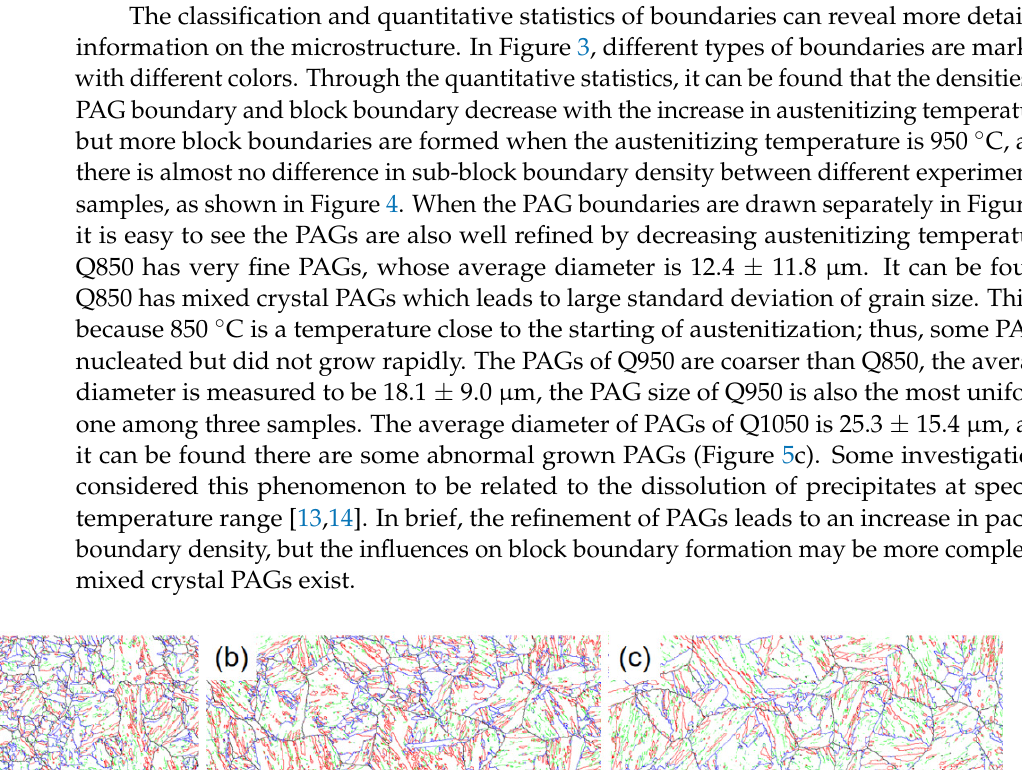
Figure 2. The density of HAGBs in three experimental samples.